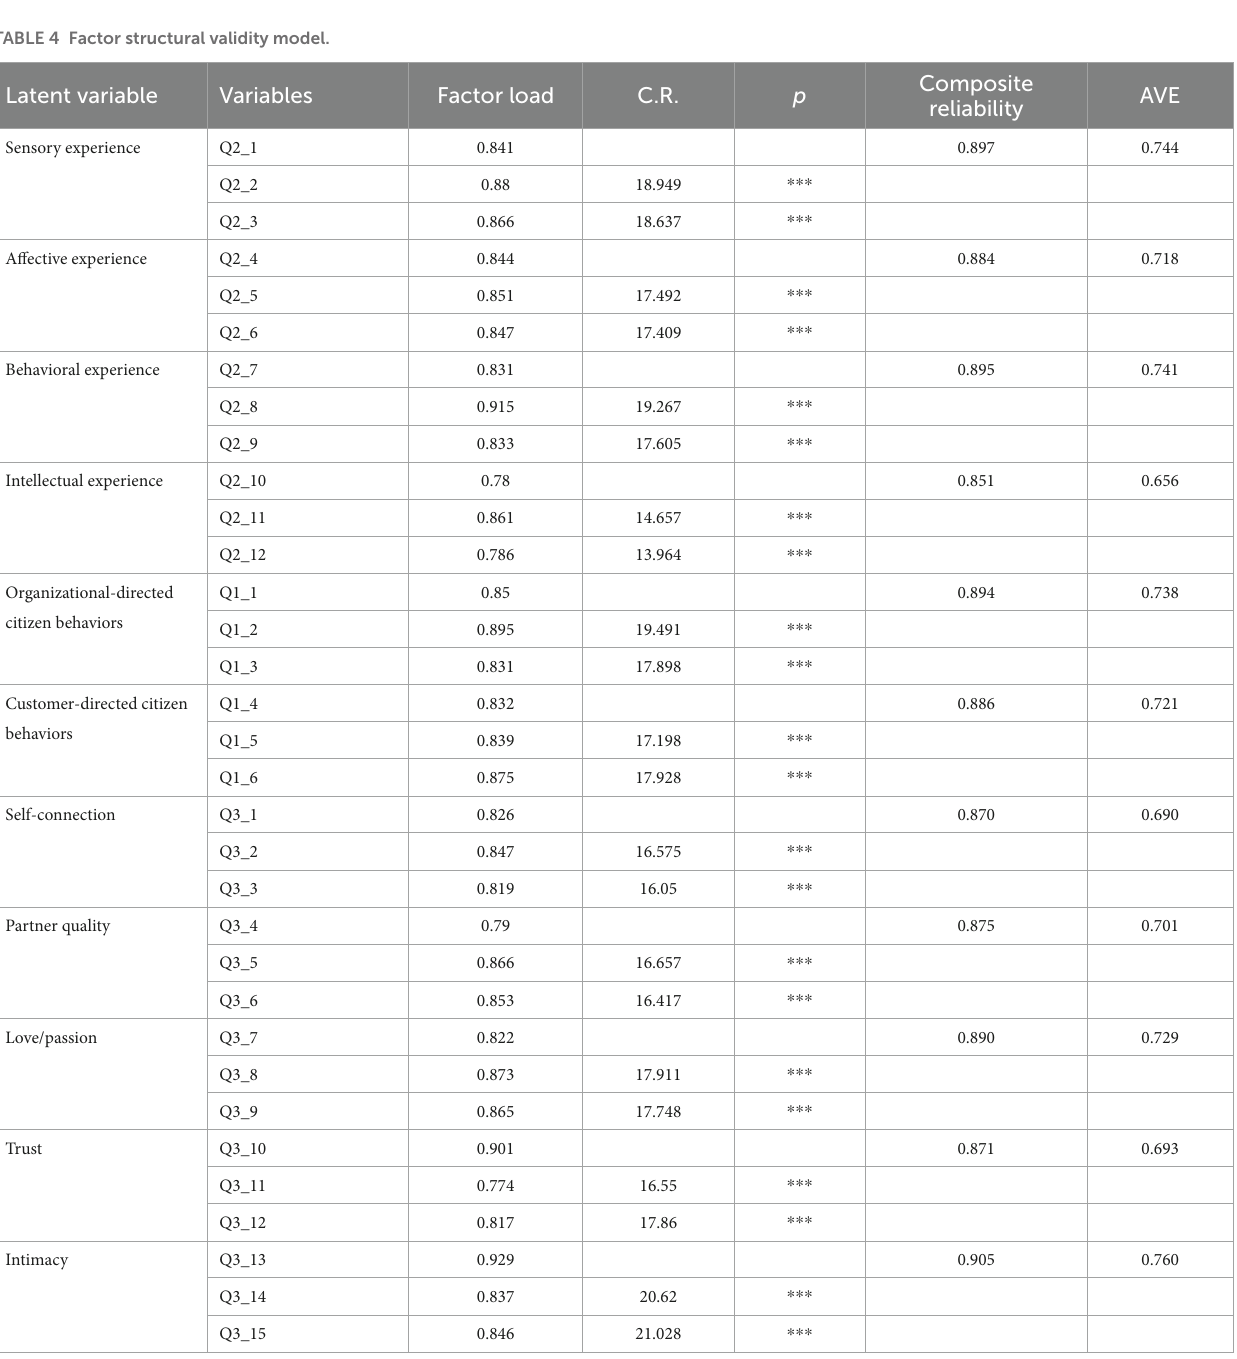
TABLE 4 Factor structural validity model.